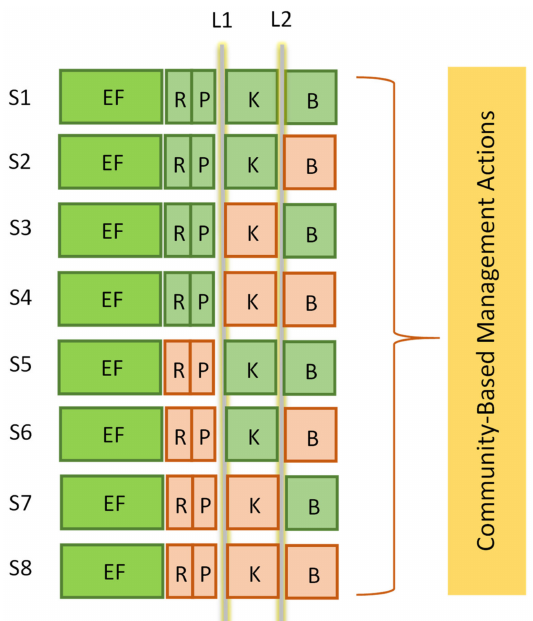
Figure 3. Eight potential service-knowledge-belief combinations (scenarios) that might produce barriers or pathways to conservation. Green symbols indicate ecosystem functions (EF), regulating (R) or provisioning (P) ecosystem services, and knowledge-based (K) or belief-based (B) cultural services; orange symbols are corresponding regulating, provisioning or cultural disservices. L1 is the knowledge lens and L2 the belief lens. Provisioning (dis)services (P) are positioned closer to the supporting services (K and B) to indicate a greater influence on stakeholder appreciations of species; however, the order of R and P may differ between stakeholders and do not necessarily have similar positive or negative values (e.g., Figure 2B). We do not include combinations with ‘neutral’ values—although examples of stakeholders indicating ‘no knowledge’ and/or expressing ‘no beliefs’ are common in social studies related to specific